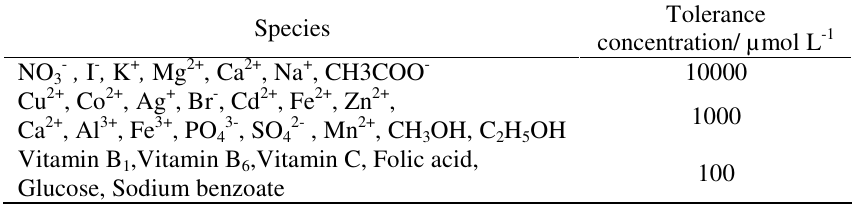
Table 3. Maximum tolerable concentration of interfering species with guaifenesin (10 µmol L -1 ) and theophylline (10 µmol L -1 ).